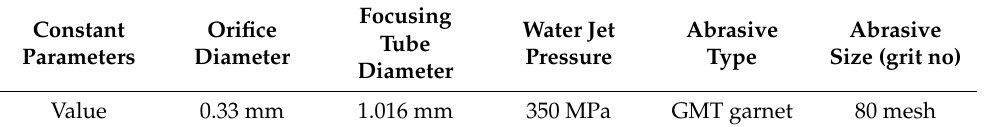
Table 1. Constant process parameters and their values used in the experiments.